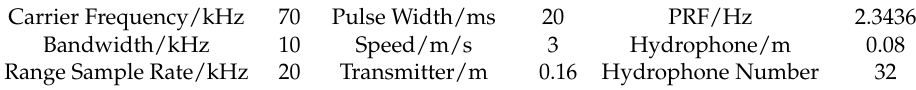
Table 1. System parameters.